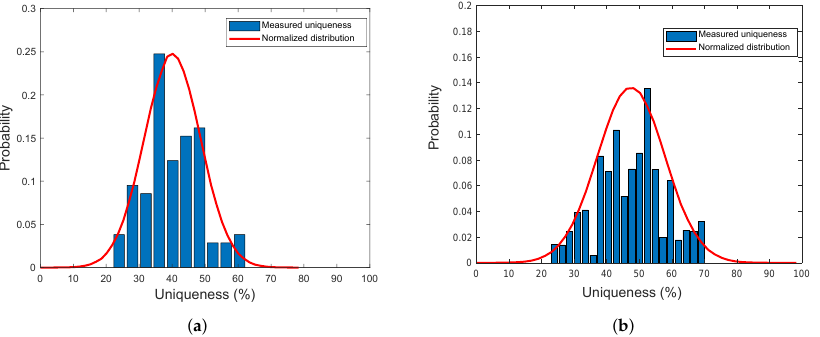
Figure 14. The uniqueness results for the proposed MMPUF design ( a ) Artix-7 FPGAs, ( b ) Kintex-7